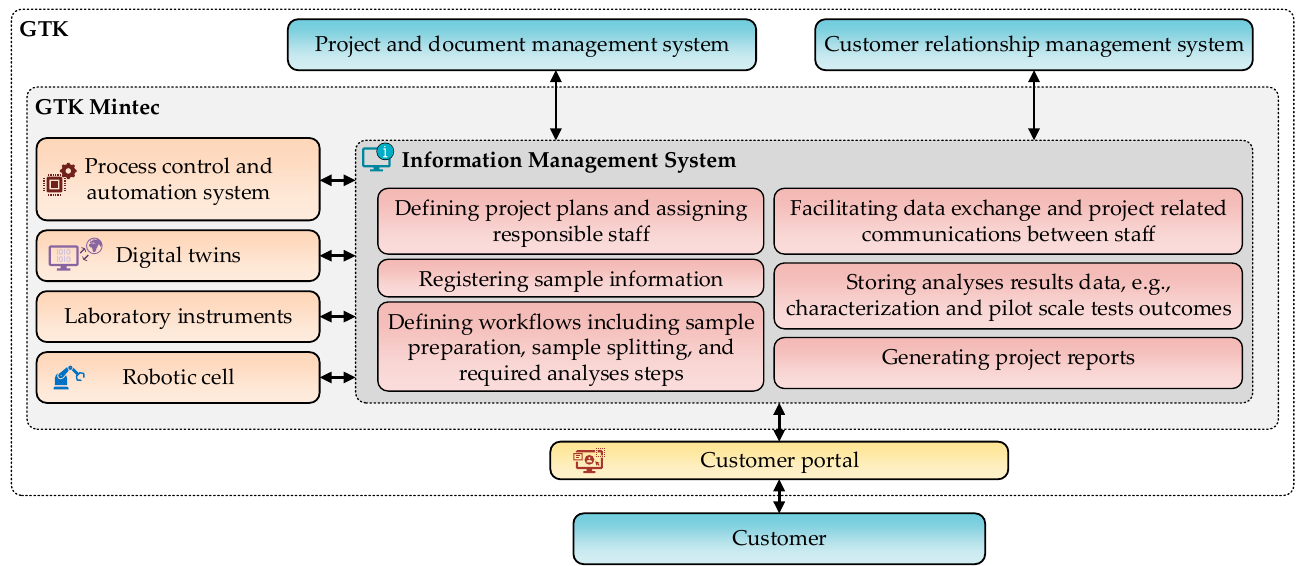
Figure 6. Context of the information management system in GTK Mintec.